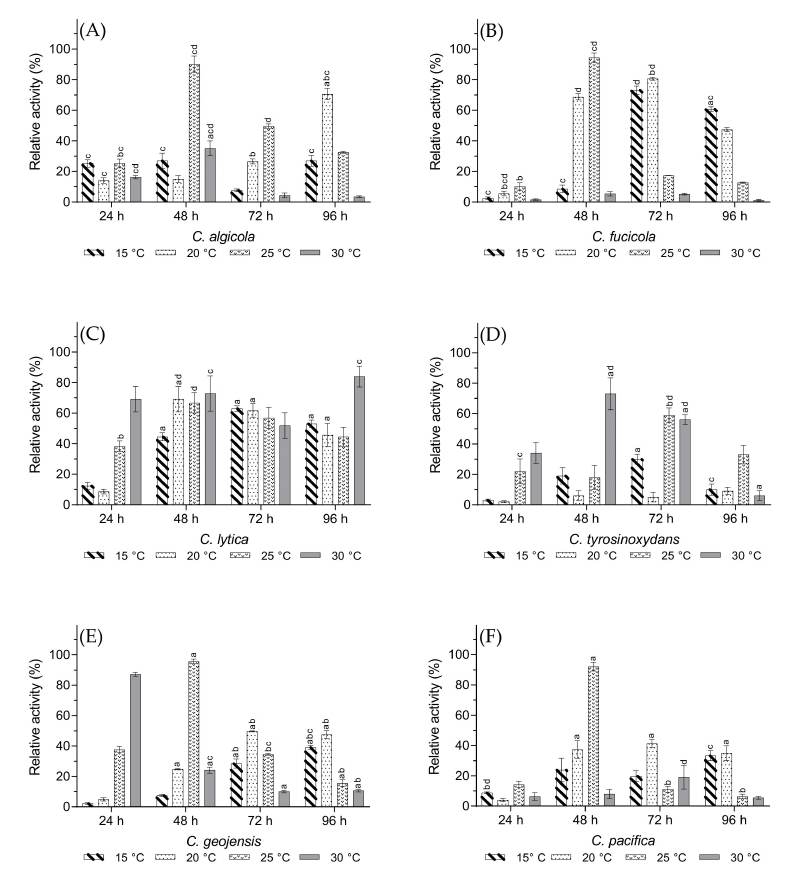
Figure 3. The effects of incubation time and temperature on carrageenase production from ( A ) C. algicola , ( B ) C. fucicola , ( C ) C. lytica , ( D ) C. tyrosinoxydans , ( E ) C. geojensis , and ( F ) C. pacifica . Values are expressed as mean ± SEM (n = 4). Data comparison was performed against different incubation time. a = when compared with 24 h, b = when compared with 48 h, c = when compared with 72 h, d = when compared with 96 h. Different lowercase letters on the bars indicate statistically significant differences from respective group using ANOVA, followed by Tukey’s comparison test ( p < 0.05).